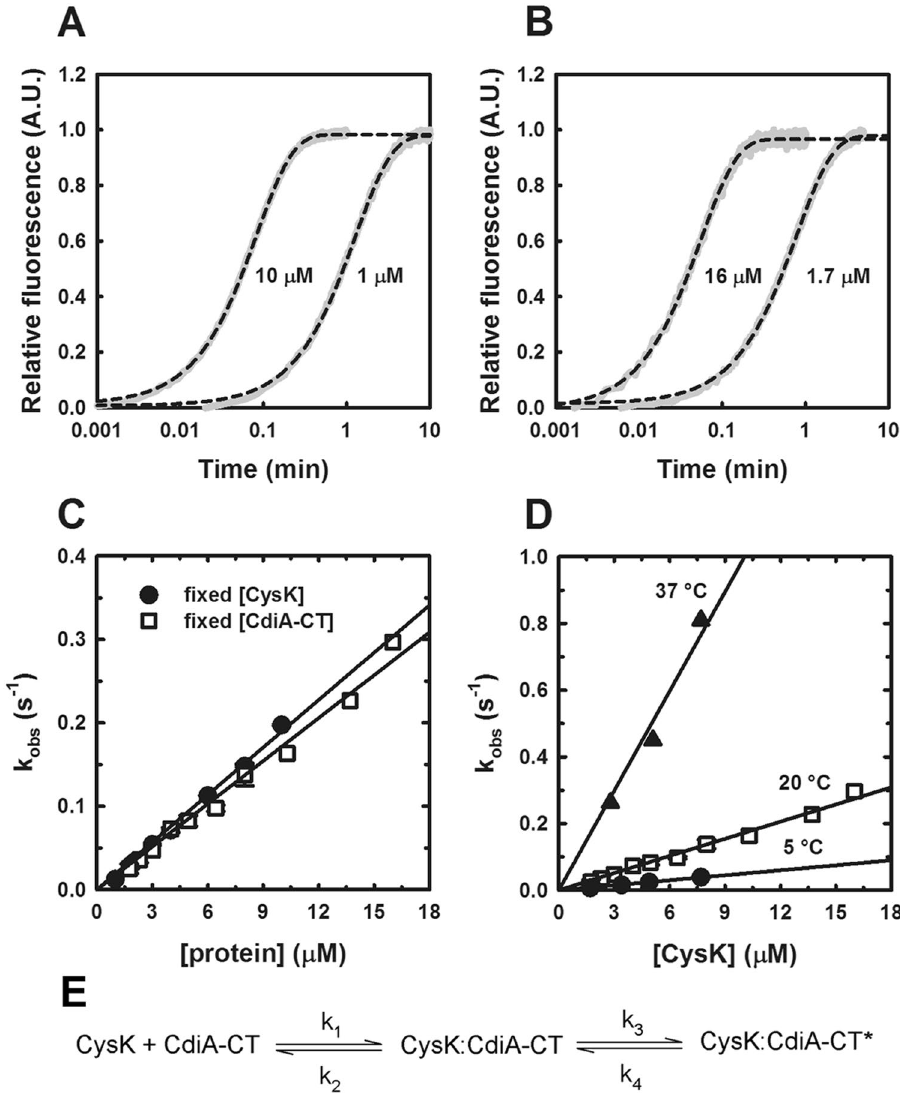
Figure 2. Pre-steady state kinetics of EcCysK:CdiA-CT assembly. ( A , B ) Representative time courses for the interaction of CdiA-CT (1 µ M and 10 µ M) with EcCysK (200 nM) (panel A) and EcCysK (1.7 µ M and 16 µ M) with CdiA-CT (270 nM) (panel B) as monitored by fluorescence emission intensity upon excitation at 412 nm. Individual traces are presented in grey, and the dashed black lines represent Eq. 5 fits to the time-course binding data. ( C ) Dependence of the observed kinetic constant (k obs ) on EcCysK and CdiA-CT concentrations. The lines represent linear equation fits with slopes of 0.019 ± 0.007 µ M − 1 ·s − 1 and 0.017 ± 0.007 µ M − 1 ·s − 1 . ( D ) Observed kinetic constant as a function of CysK concentration and temperature. Solid lines represent linear equation fits with slopes of 0.099 ± 0.019 µ M − 1 ·s − 1 (37 °C), 0.017 ± 0.007 µ M − 1 ·s − 1 (20 °C) and 0.005 ± 0.0003 µ M − 1 ·s − 1 (5 °C). ( E ) Two-step model for EcCysK:CdiA-CT complex formation including a slow conformational change. CysK:CdiA-CT is the encounter complex, and CysK:CdiA-CT * corresponds to the isomerized, nucleolytic